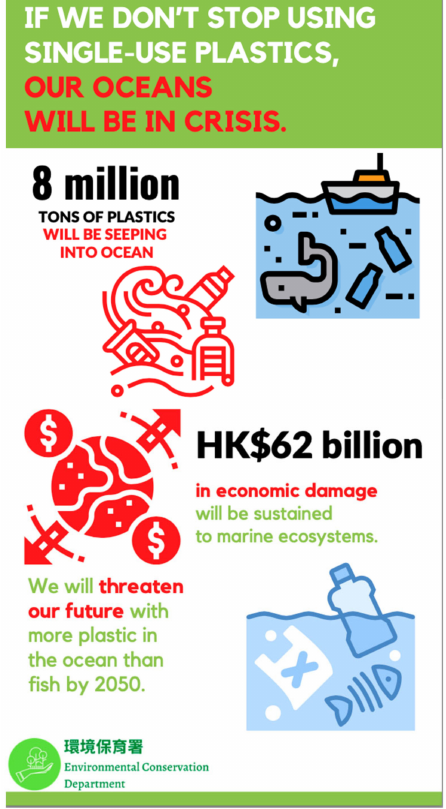
Figure A11. Example of condition 11: loss * infographic * government.